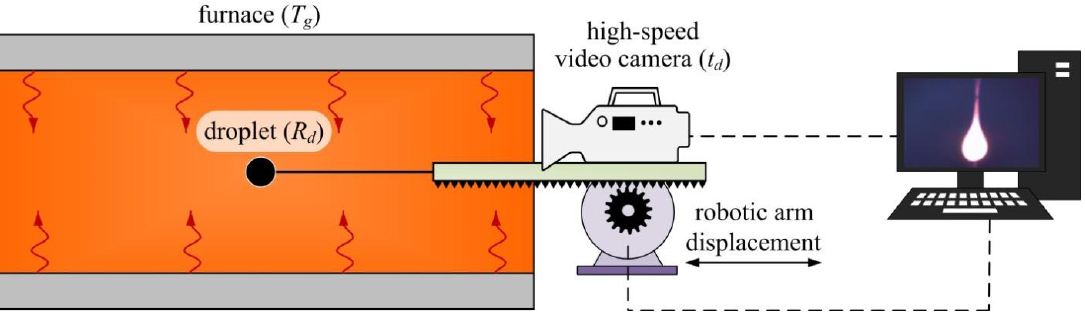
Figure 3. Scheme of experimental setup.